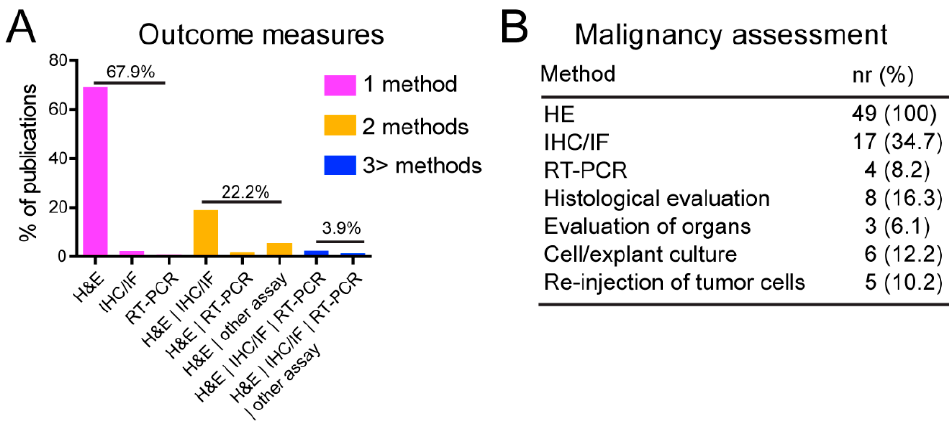
Figure 4. Outcome measures and malignancy assessment. ( A ) Techniques and their combinations used for tumor assessment. ( B ) Method(s) and the numbers (%) of publications assessing potential malignant components of the tumors.